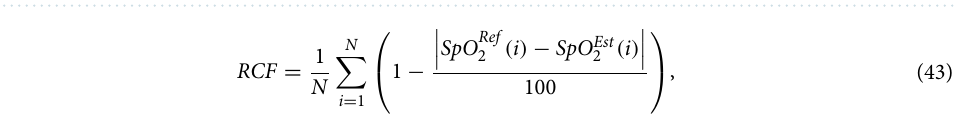
Figure 13. Scatter plot and Bland–Altman analysis of the estimated versus reference (measured) %SpO 2 values for the blood-vessel